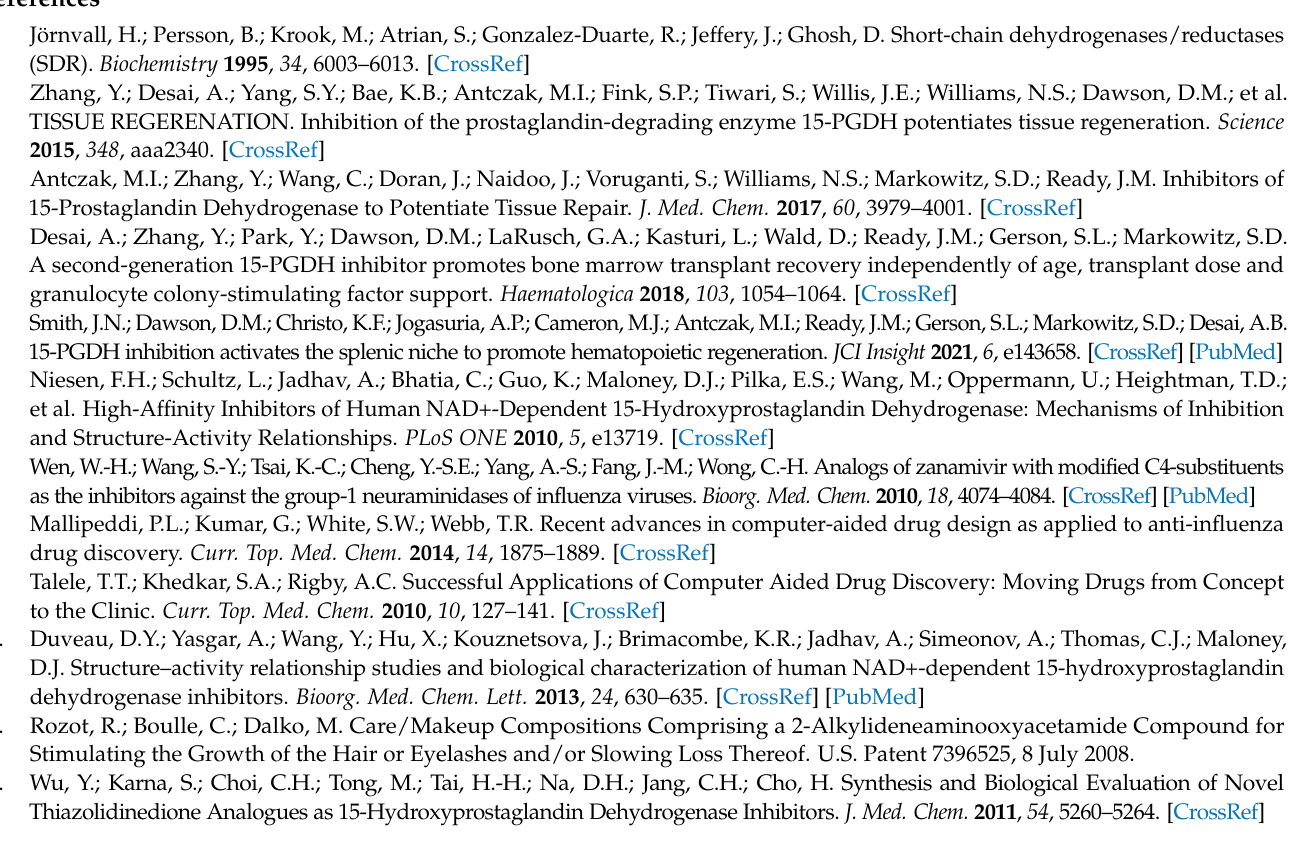
Supplementary Materials: Supplementary Figure S1: Castp predicted binding site is shown in surface representation in green and PGDH is shown in gray in ribbon style. The predicted binding site has an area of 545.4 ˙A 2 and volume of 316.7 ˙A 3 . Supplementary Figure S2: Overlay of 7 α -HSDH co-crystal structure over the 15-PGDH-NAD+-PGE2 docked model. 15-OH of PGE2 docked model exhibits hydrogen-bond interactions with conserved residues Ser138 and Tyr151 similar to 7-OXO- GCDCA substrate in 7 α -HSDH co-crystal structure. 7 α -HSDH residues and substrate 7-OXO-GCDCA is colored teal while 15-PGDH residues are colored green. PGE2 is colored gold. Supplementary Table S1: Docked poses of published PGDH inhibitors. Supplementary Table S2: Thermal shift data showing ( R )-S(O)-SW033291 binding to 15-PGDH-NAD+ and 15-PGDH NADH